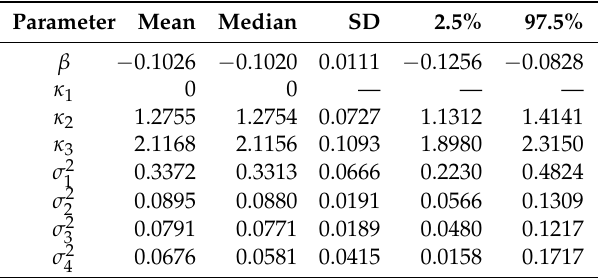
Table 5. Aneurysm data: estimated posterior means, medians, standard deviations (SD), and 2.5% and 97.5% percentiles.